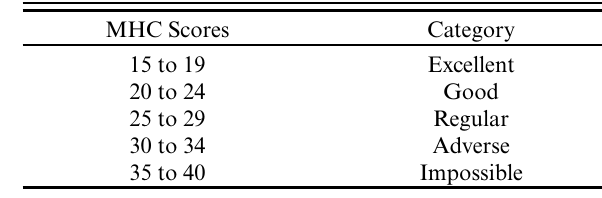
Table 3 . Mean Historical Climate for Tourism (MHC) scores and climate category (Delgado Castro and Gálvez Soler